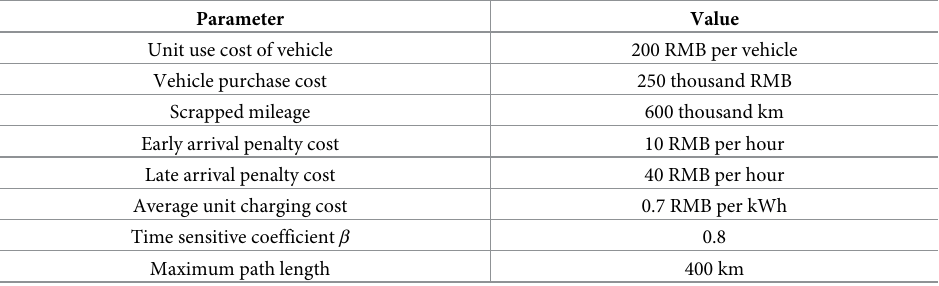
Table 5. Cost parameters related to distribution